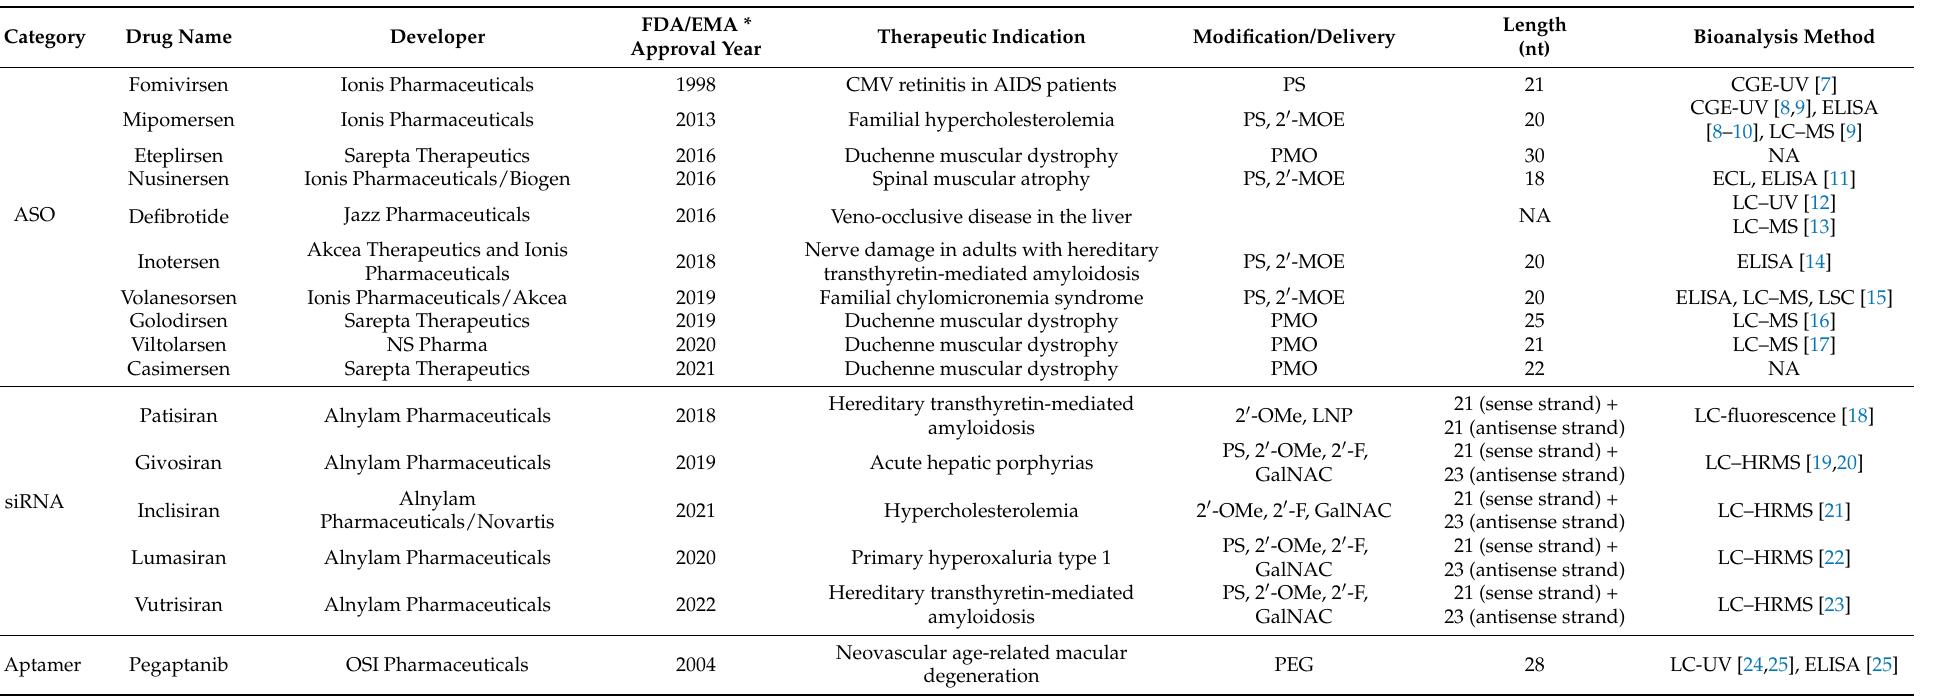
Table 1. List of FDA- and EMA-approved oligonucleotide drugs and reported bioanalytical methods (until August